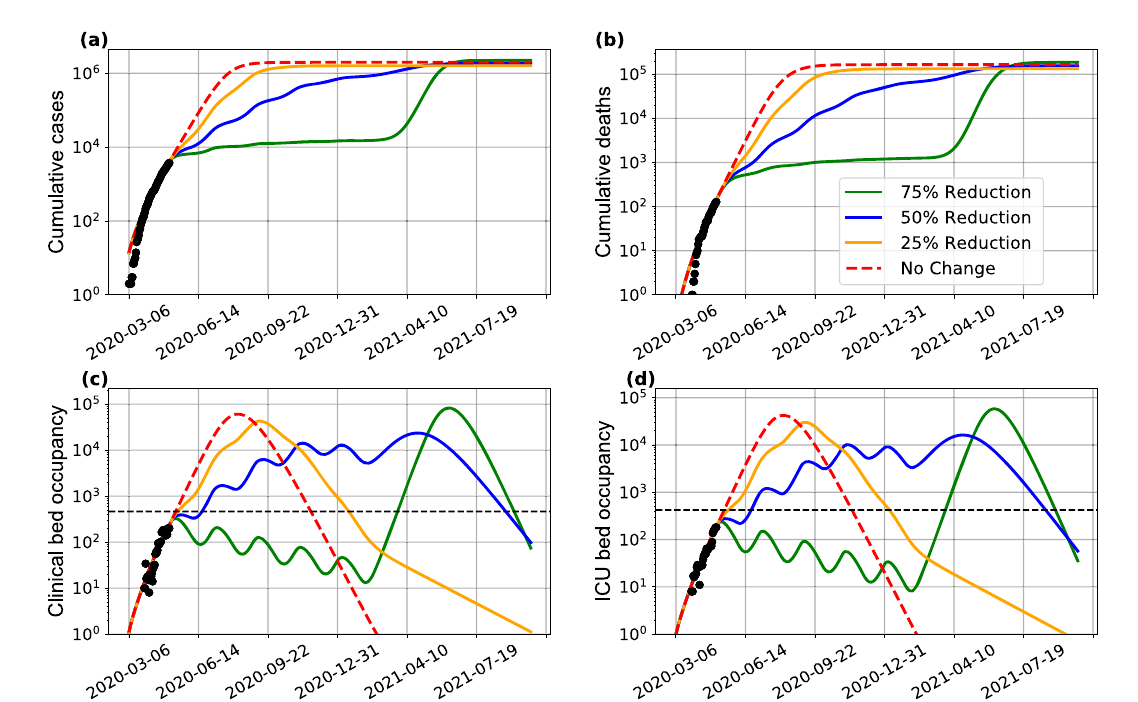
Fig. 5 Effect of periodic interventions in Bahia. Simulated impact on the ( a ) number of cases, ( b ) deaths, ( c ) clinical hospitalization, and ( d ) ICU bed requirements at the state level. The transmission function β , as in Eq. (1), is de fi ned by considering a reduction of 25% (yellow curves), 50% (blue curves), and 75% (green curves) on the β 1 parameter. The red curves consider a scenario of no reduction in β 1 , and the period is the intervention window of 30 days. The dashed horizontal lines in ( c ) and ( d ) indicate the total number of clinical and ICU beds available in the state, respectively, in that moment. The black dots correspond to the actual number of cases ( a ), deaths ( b ), and hospital bed occupancy ( c ) – ( d ). The assumed parameter values are shown in Supplementary Table 3. Raw data from March 6 to May 4, 2020 are shown in this